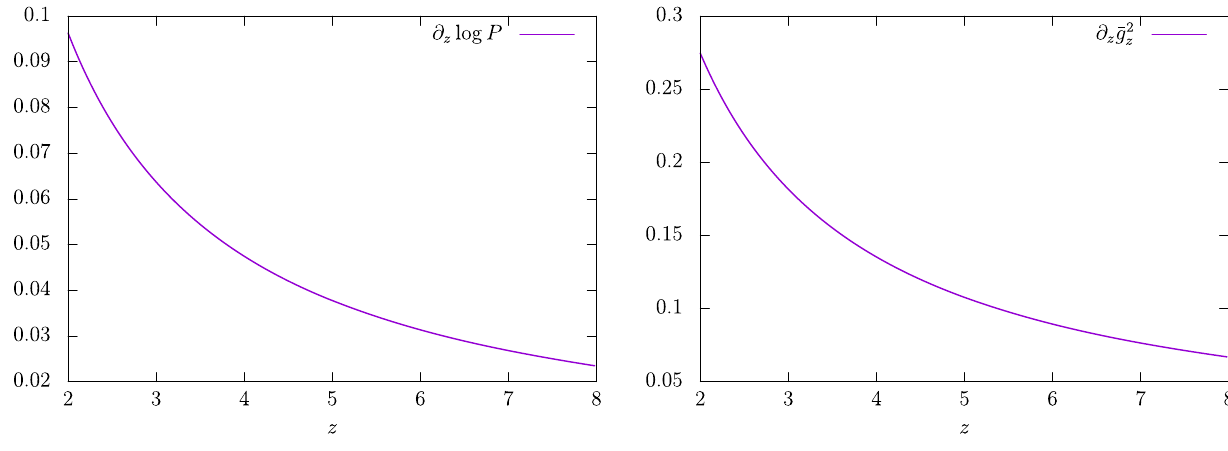
Fig. 11 a The derivative ∂ z log P = η M / z . b The full derivative of the coupling Eq. (F.8)